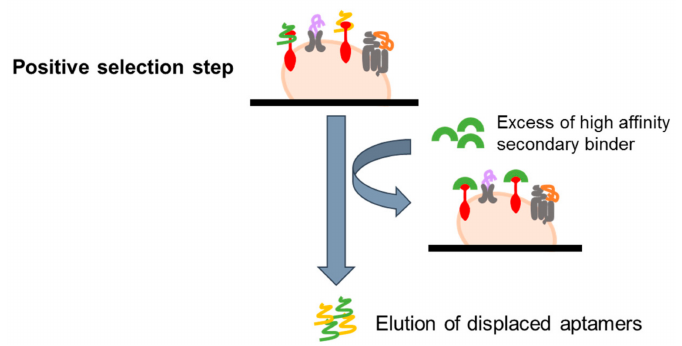
Figure 5. Scheme of Ligand-Guided Selection (LIGS). An excess of high affinity secondary binder (i.e., a monoclonal antibody) for the chosen target is added following the selection step, in order to displace and elute bound aptamers by competing with